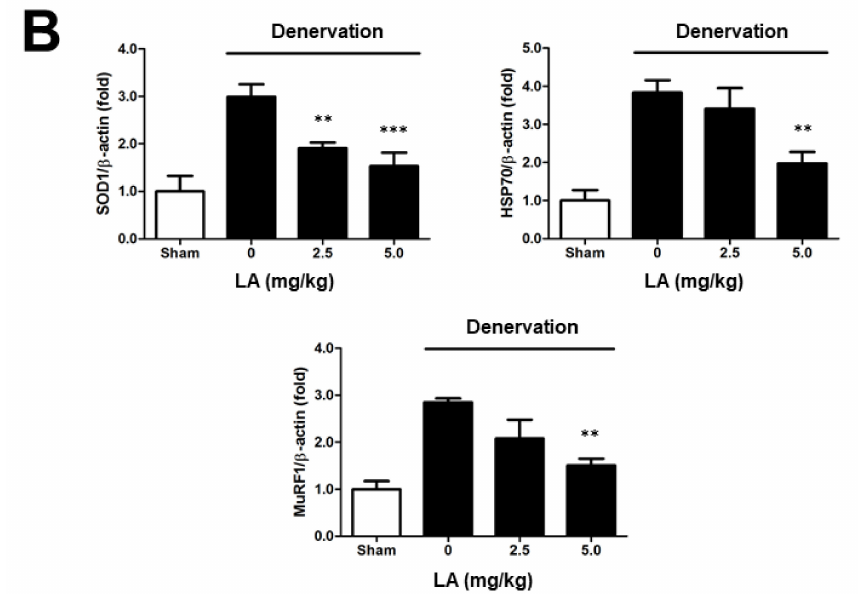
Figure 6. Linoleic acid decreases SOD1, HSP70, and MuRF1 protein expression in sciatic denervation- induced muscle atrophy of C57BL/6 mice. Muscle atrophy was induced in C57BL/6 mice by sciatic denervation. Protein expression level as analyzed by SDS-PAGE. Lysis of muscle tissue and protein extraction was performed using the PRO-PREP protein extraction kit. ( A ) Effect of LA on SOD1, HSP70, and MuRF1 protein expression level by sciatic denervation-induced muscle atrophy in mice. ( B ) Relative density of SOD1, HSP70, and MuRF1 protein expression level. Each value indicates the mean ± SD ( n = 6); ** p < 0.01, *** p < 0.001 vs. sciatic denervation